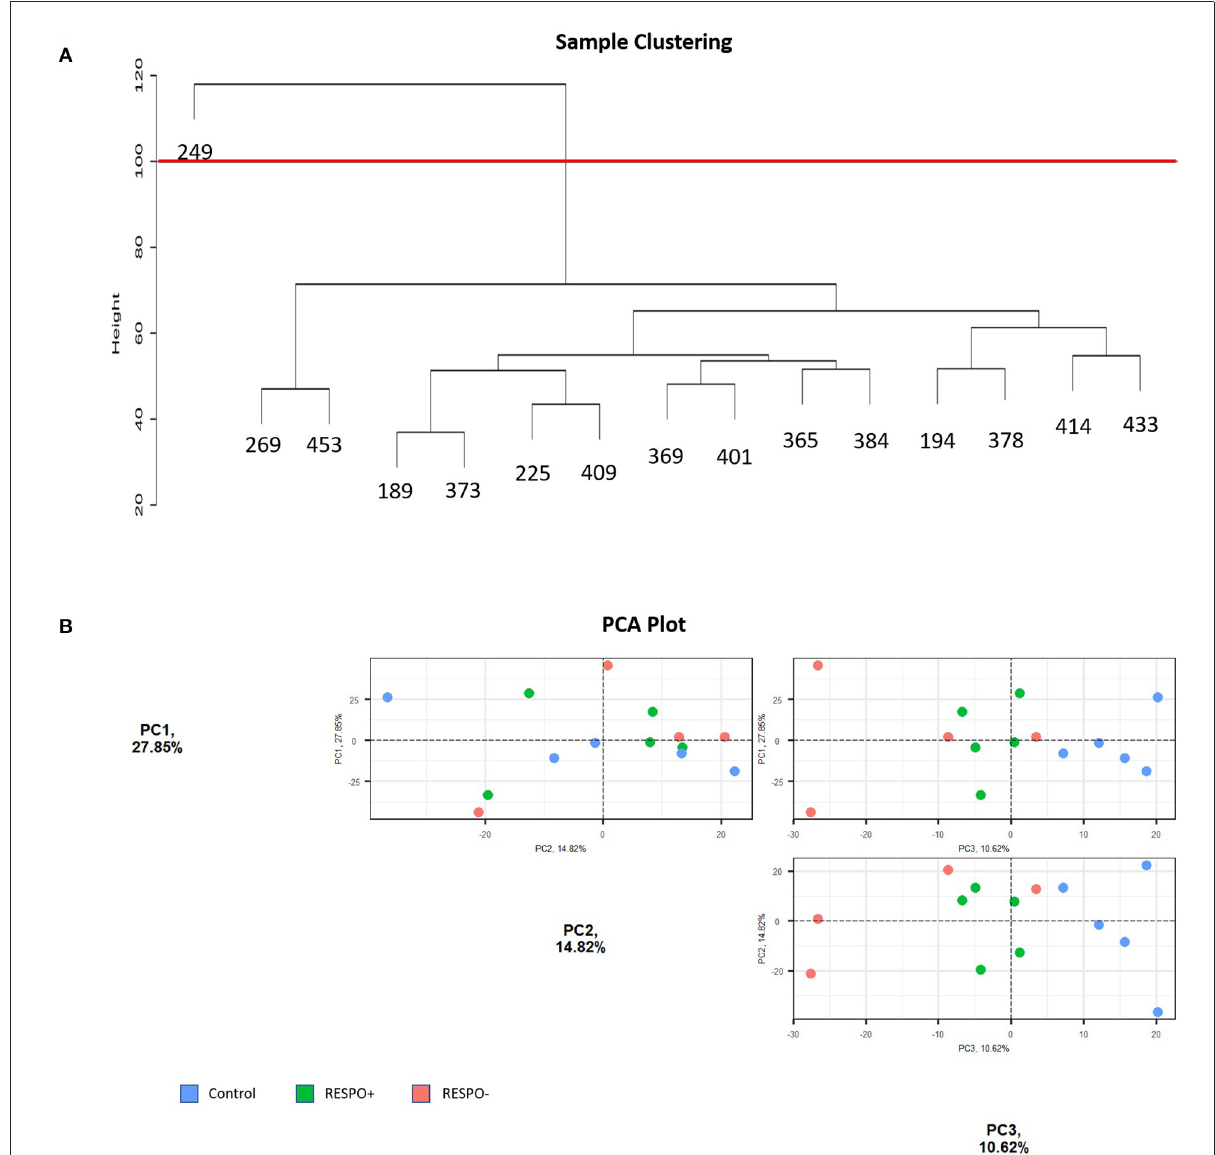
FIGURE2 Sample Distribution of the RNA-Seq data. (A) Hierarchical clustering of samples based on Euclidean distance. The red line represents the threshold fixed to discard outliers (B) Principal Component Analysis (PCA) plots for PC1, PC2, and PC3 of milk somatic cell transcriptomes from control (blue) and more (RESPO + ; green) or less (RESPO–; red) responsive goats to a diet inducing milk fat depression (MFD).